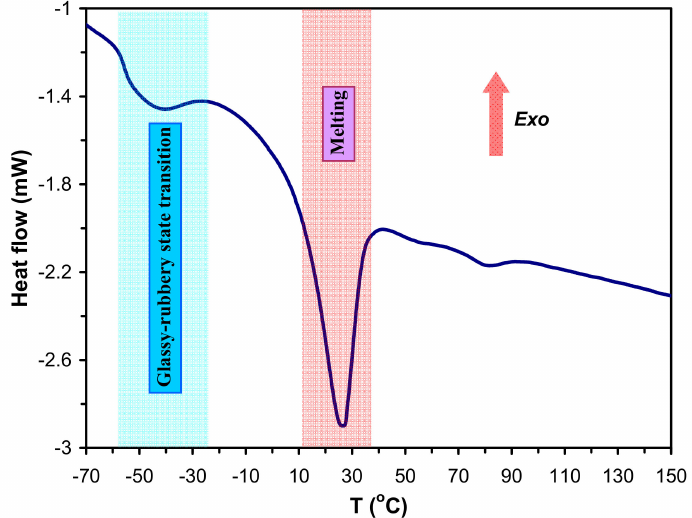
Figure 9. Representative DSC trace for the sample SPUR-3 (T g = − 56 ◦ C, and T m = 26 ◦ C) (The DSC traces for the samples SPUR-1, SPUR-2, SPUR-4 and SPUR-5 can be seen in Figures S4–S7, respectively in the Supplementary Materials).